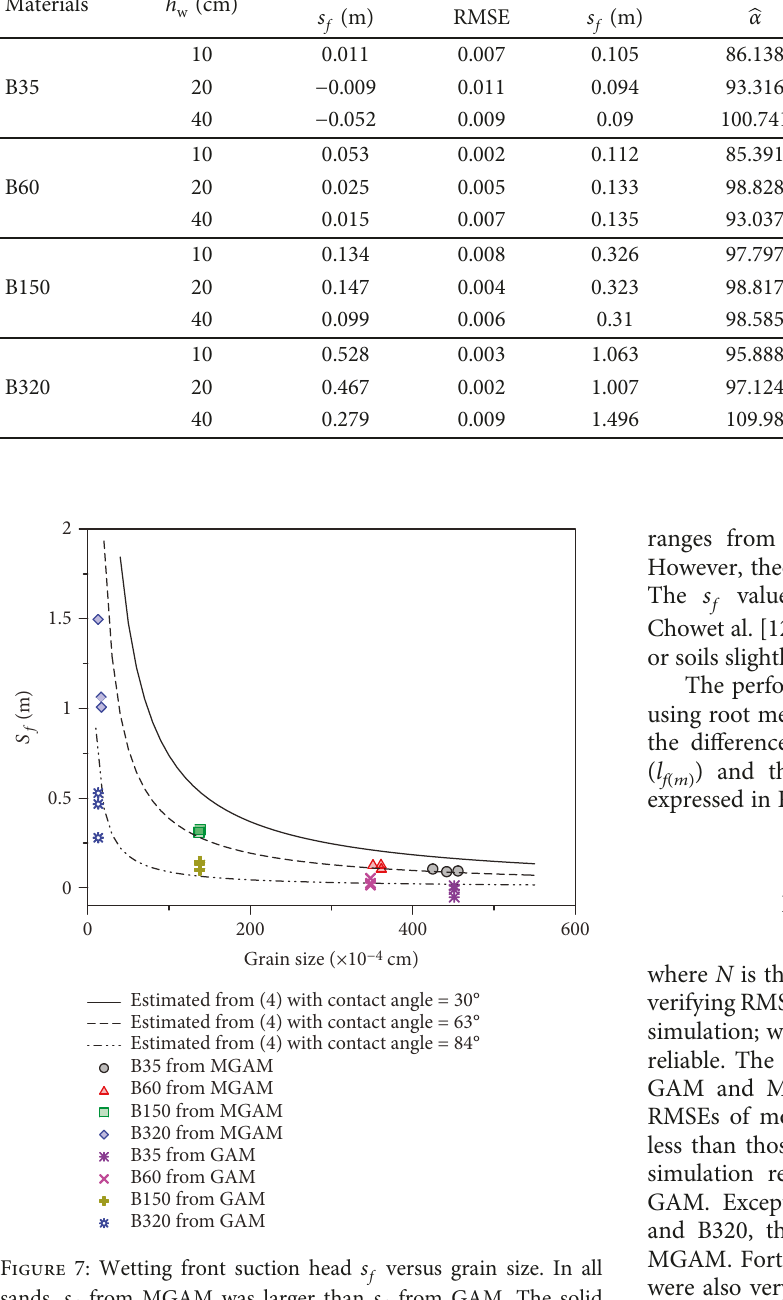
Table 2: Model parameters and RMSE of GAM and MGAM for downward in fi ltration simulation. Materials